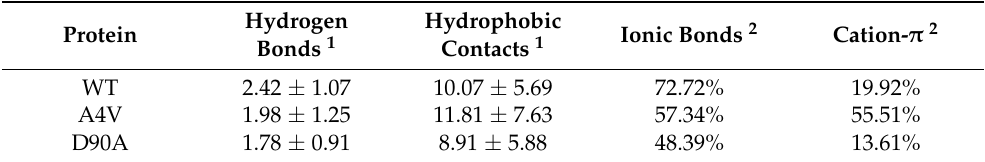
Table 2. Interactions between SBL-1 and SOD1 protein. Protein